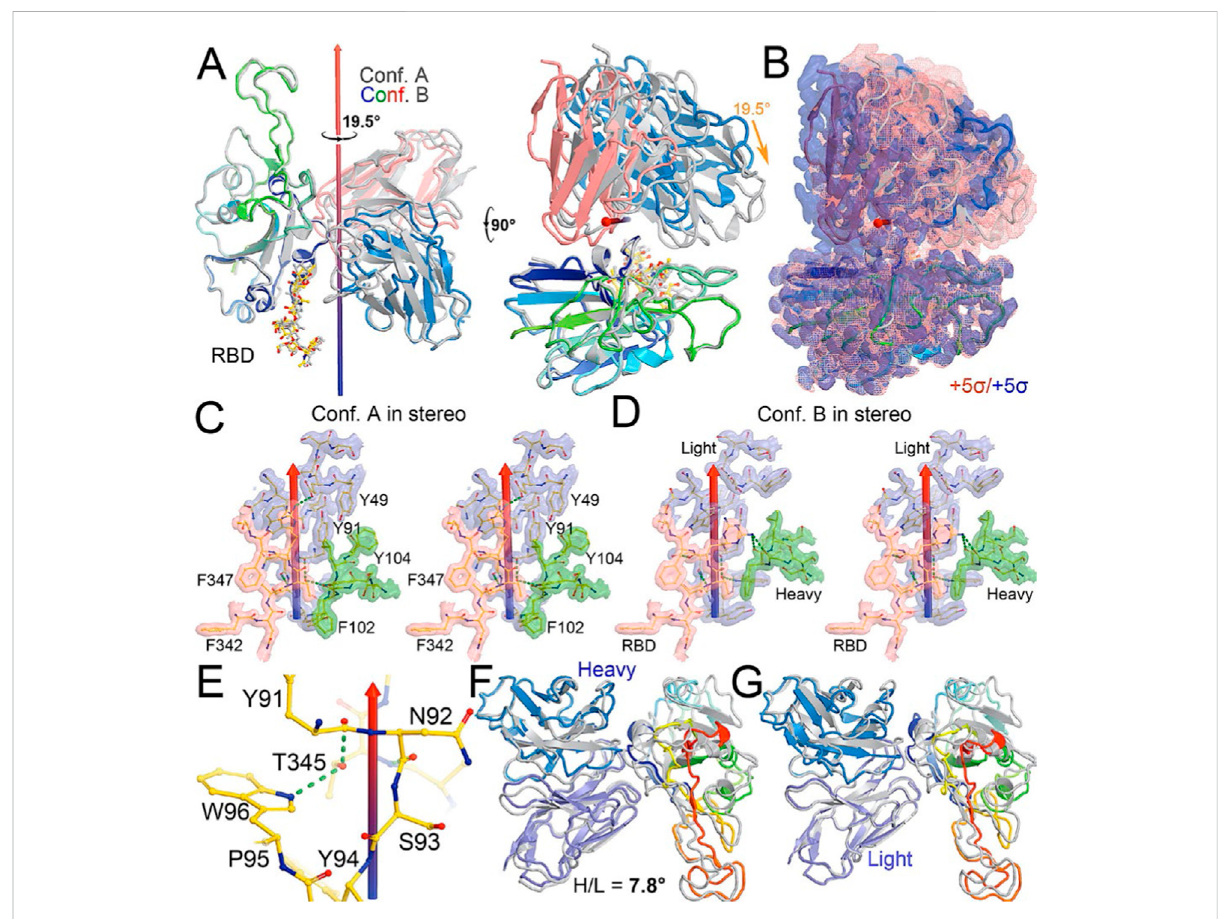
FIGURE 2 ComparisonbetweenconformationsAandBoftheNAb-spikecomplex. (A) Twoorthogonalviewsofcomparisonwithrotationalaxisandangle indicateduponalignmentoftheRBD(rainbowcolor)betweenconformationA(grey)andB(multicolor). (B) CorrespondingMD-ESPmapscontoured at +5 σ . (C) Interactions of the RBD and heavy/light chains near the rotational axis in stereodiagram of conformation (A). (D) Conformation B in stereodiagram. (E) Conserved interaction surrounding T345 in the two conformations. (F) Alignment of heavy chain between the two conformations. (G) Alignment of light